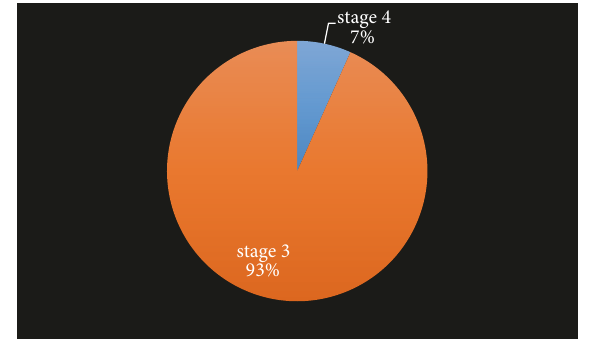
Figure 2: Relative prevalence of moderate-to-severe CKD among males and females.